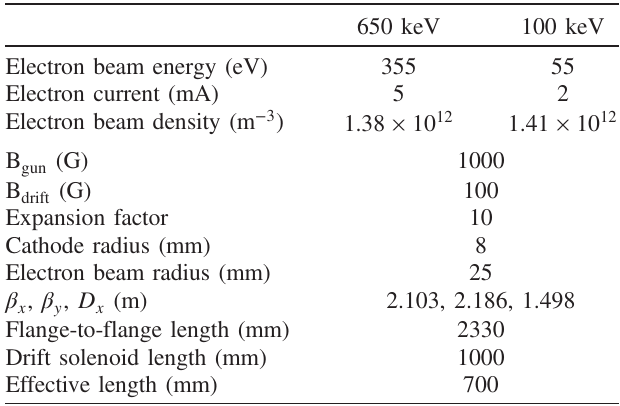
TABLE I. Nominal electron cooler parameters for